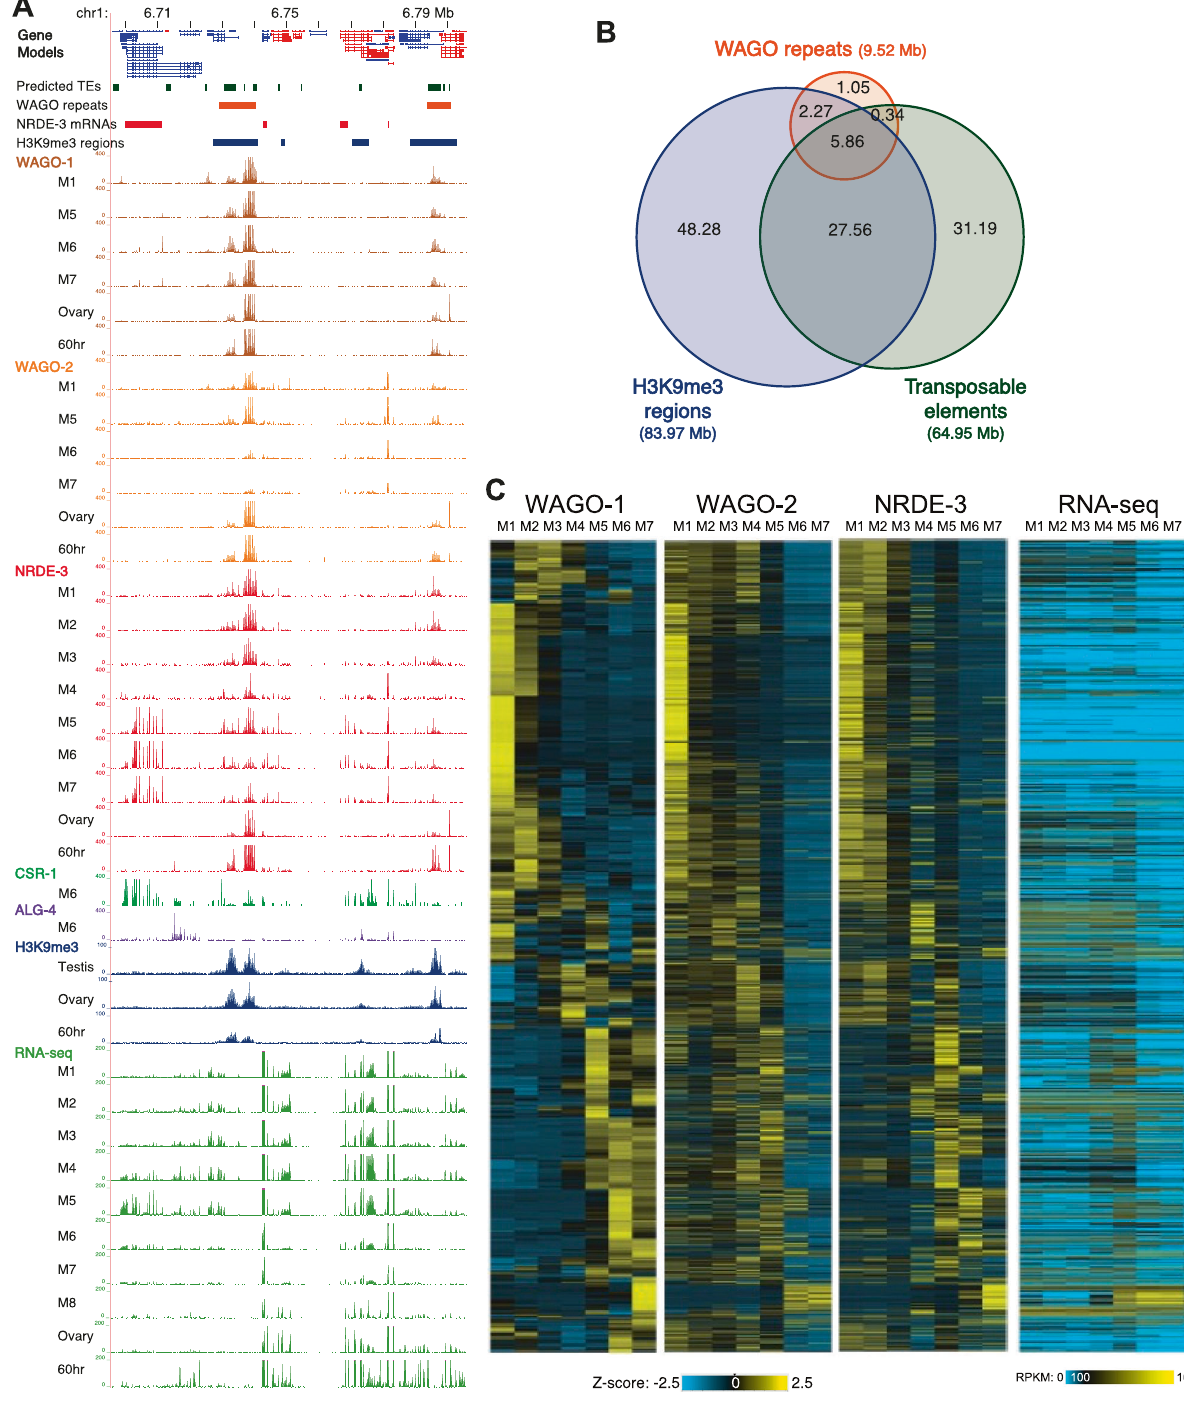
Fig. 5 AsWAGO-1, AsWAGO-2, and AsNRDE-3 associated small RNAs target repeats during spermatogenesis. A Genome browser view of a region of chromosome 1 illustrating Argonaute associated small RNAs, RNA expression (RNA-seq), and H3K9me3 levels. Only spermatogenesis stages that exhibit changes in expression or changes in Argonaute small RNA or mRNA expression are illustrated. Note NRDE-3 associated small RNAs change their targets from repeats to mRNAs during pachytene and late meiosis (M5 – M7). B Ascaris WAGO-repeat targets largely overlap with genomic H3K9me3 levels and/ or the presence of transposable elements. C siRNA levels to the top targets (top 1776 WAGO-repeat loci; see Supplementary Table 3) for each WAGO during spermatogenesis. Heatmaps illustrate the standard Z-score (converted from rpkm) showing changes in expression of siRNAs associated with AsWAGO-1, AsWAGO-2, and AsNRDE-3. The RNA expression (rpkm) of the targets is also illustrated (right). Targeted loci were sorted based on the same order in the four heatmaps. Source data are provided as a Source Data fi